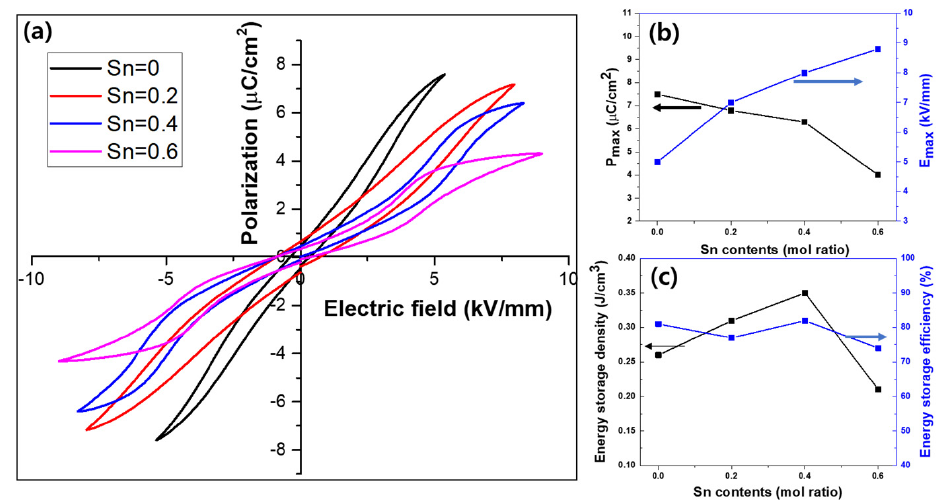
Figure 7. Electrical properties of PLZST composition according to the amount of Sn 4+ substitution ( a ) hysteresis curve, ( b ) maximum polarization and breakdown electric field, and ( c ) energy storage density (W) and efficiency ( ŋ ).